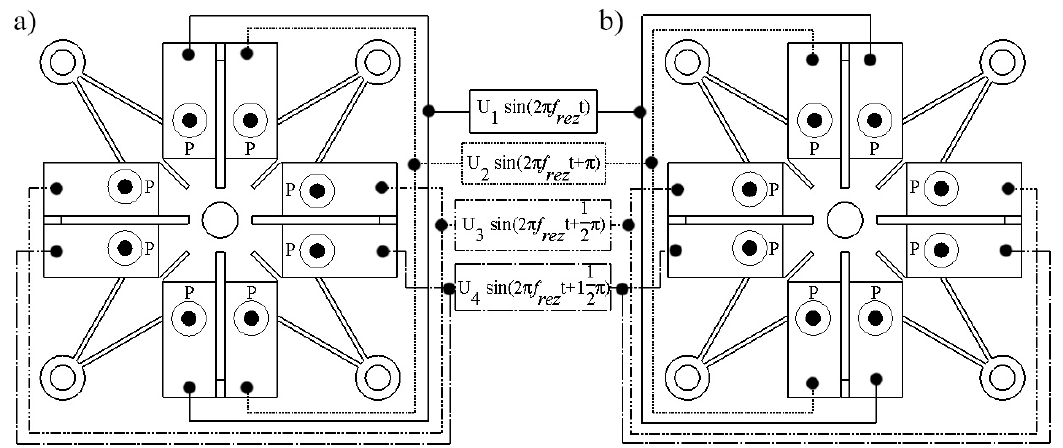
Figure 3. Excitation schematics of the motor; ( a )—top of the motor; ( b )—bottom of the motor; f rez —operation frequency of the motor; P—polarization of piezo ceramic plates.